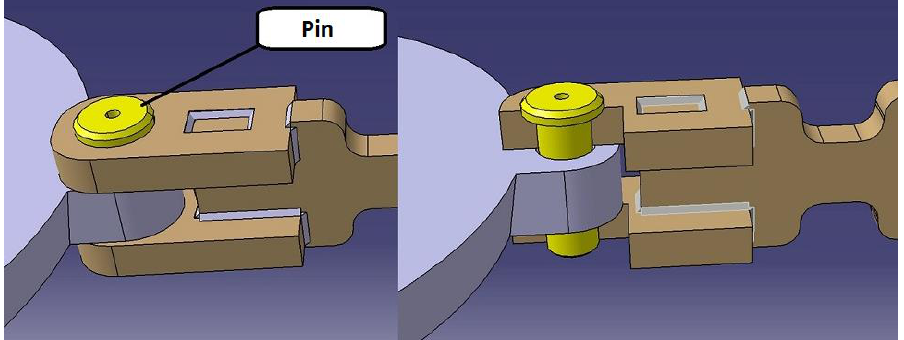
Figure 10. Detachable connection of the crushing hammer with the crusher head.